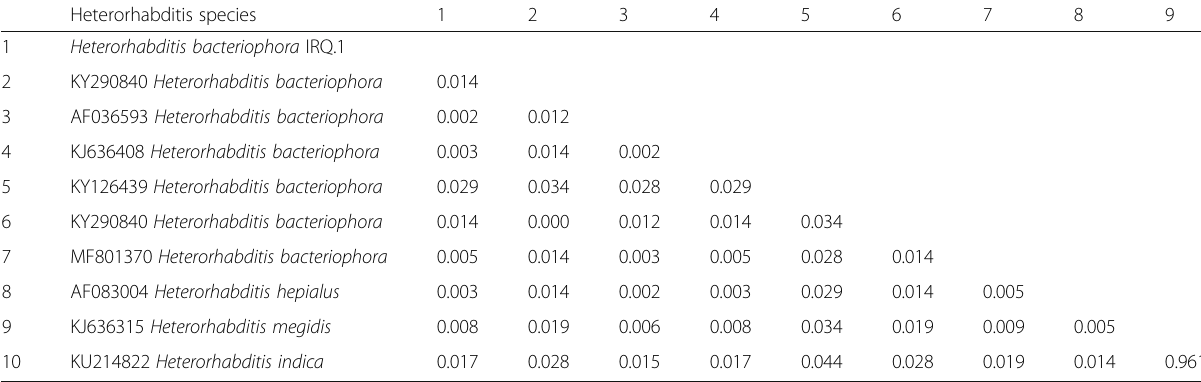
Table 2 Pairwise comparison on the number of nucleotide differences among some of Heterorhabditis species and isolates with Heterorhabditis bacteriophora isolate IRQ.1 based on 18S sequences Heterorhabditis species